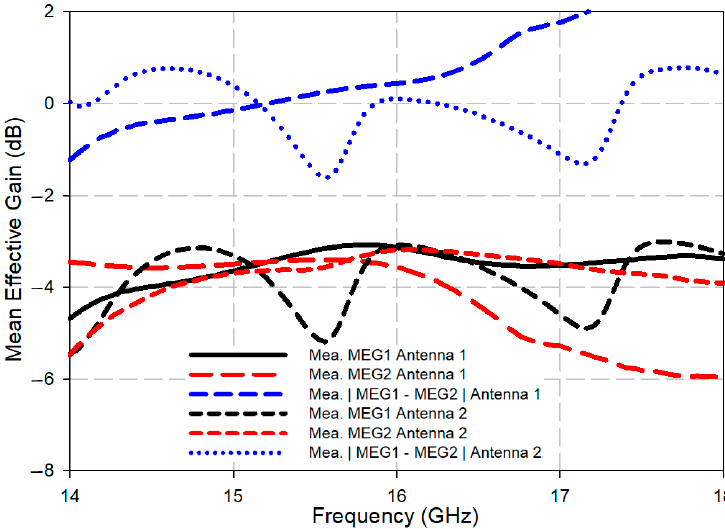
Figure 16. Measurement of the mean effective gain (MEG). Table 3. Comparison between the proposed and existing MIMO